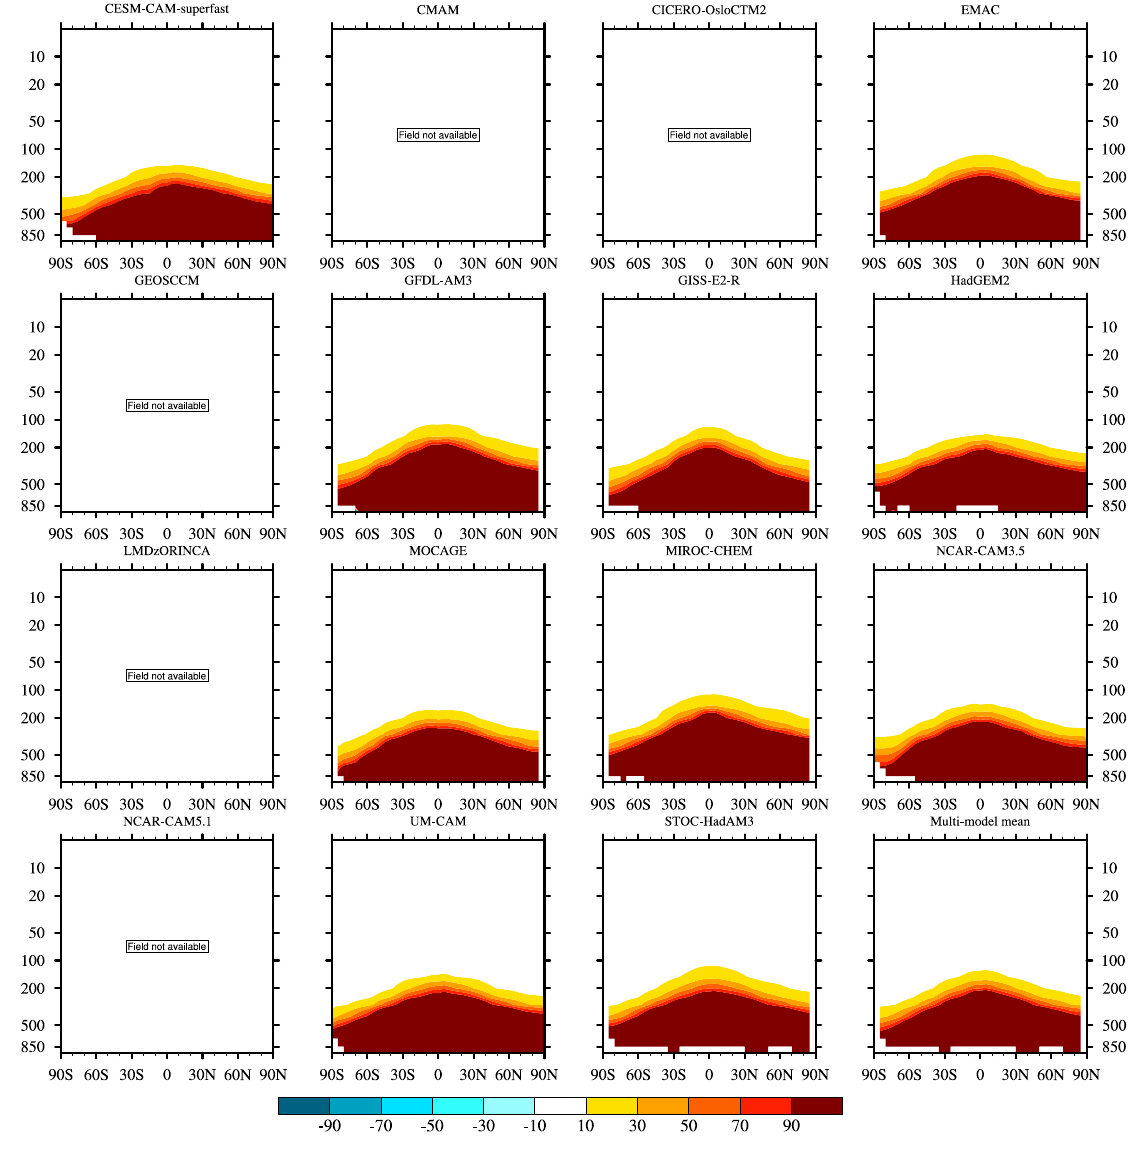
Figure 10c. Same as Figure 10b but for RCP8.5. Fig. 10c. Same as Fig. 10b but for RCP8.5. Fig. 10c. Same as (b) but for